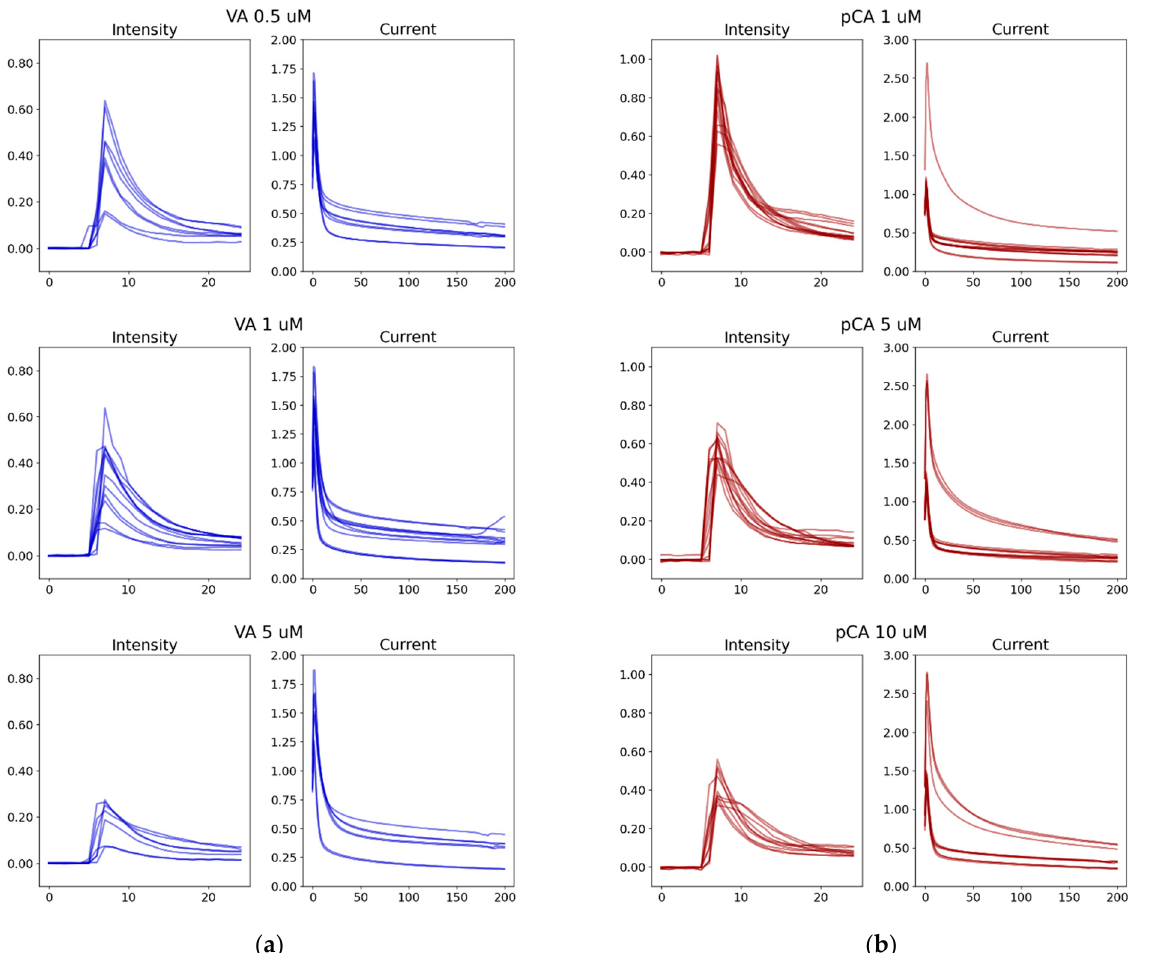
Figure 3. Selected examples of time sereis of ECL intensity and current from seven to eight different electrodes: ( a ) Vanillic acid (0.5, 1, and 5 μ M) in blue; ( b ) p -Coumaric acid (1, 5, and 10 μ M) in red. Horizontal axes represent measurement frame and vertical axes represent the normalized signal (arbitrary unit). These time series data were used to train ML models for Section 3.2. The data shows the variability of data that are fed into the ML algorithm. VA: Vanillic acid; pCA: p -Coumaric acid.